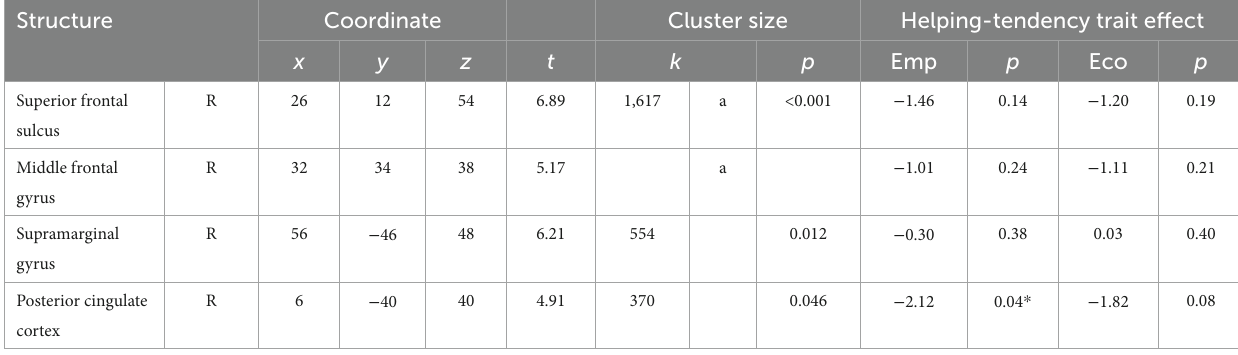
TABLE 3 Differential activation during helping decision (EmpDec >